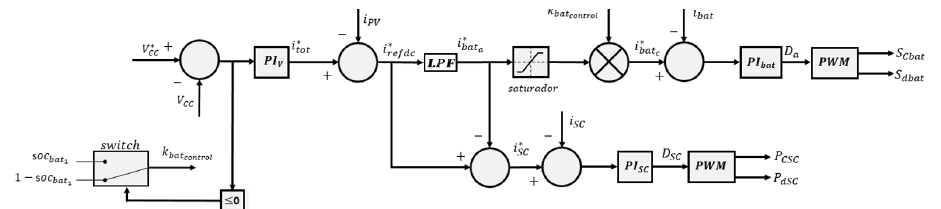
Figure 5. Battery and supercapacitor control block